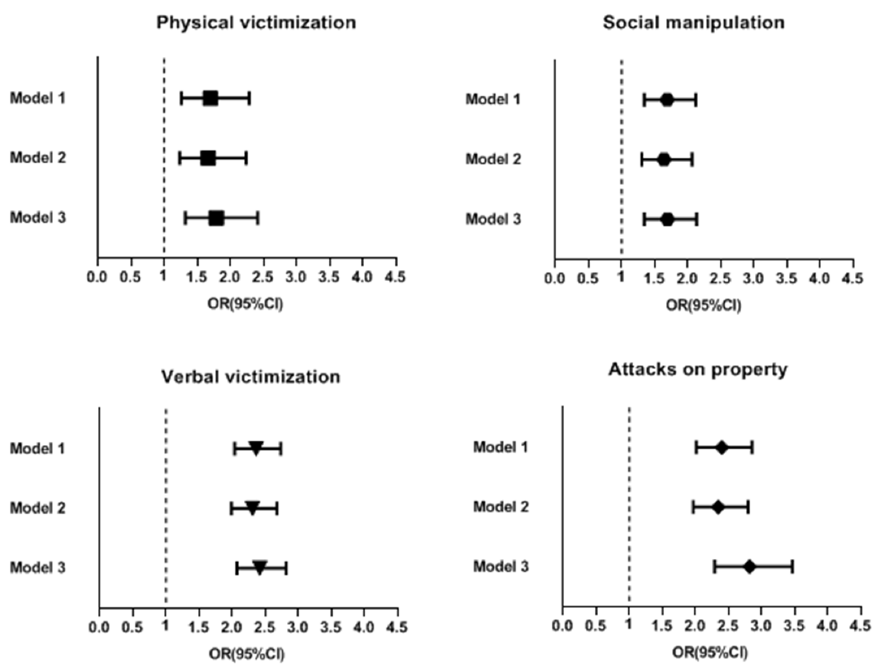
Figure 2. Crude ORs and adjusted odds ratios for the incidence of various kinds of bullying victimization before and during the pandemic (error bars represent 95% confidence intervals).